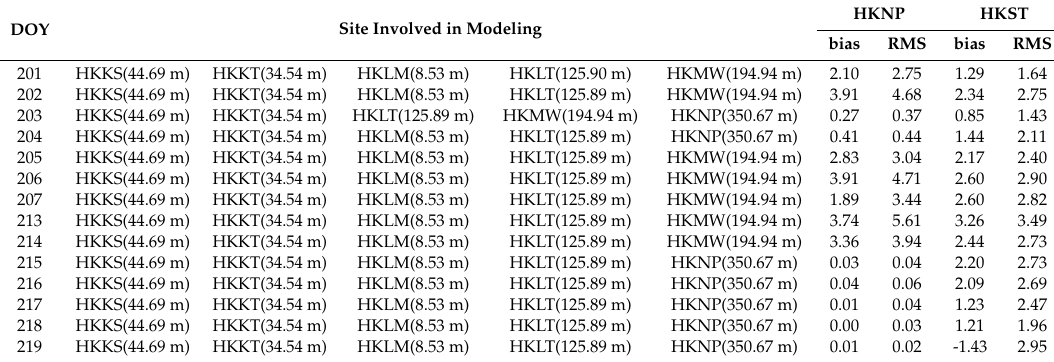
Table 5. Precision of the local troposphere fusion model for each station.